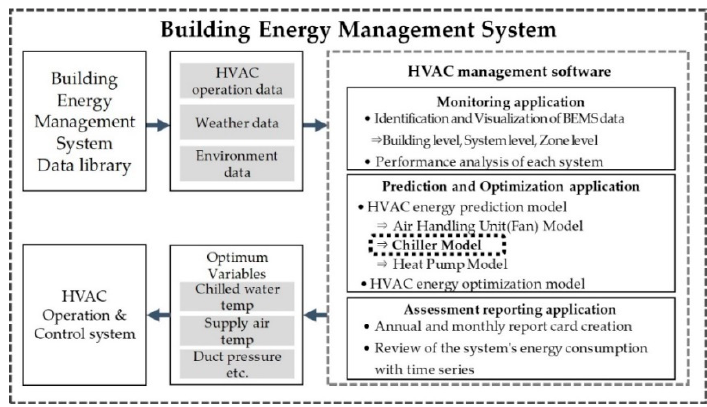
Figure 1. Schematic diagram of centralized heating, ventilation, and air conditioning (HVAC) management software, energy performance prediction and optimization function (EPPOF).